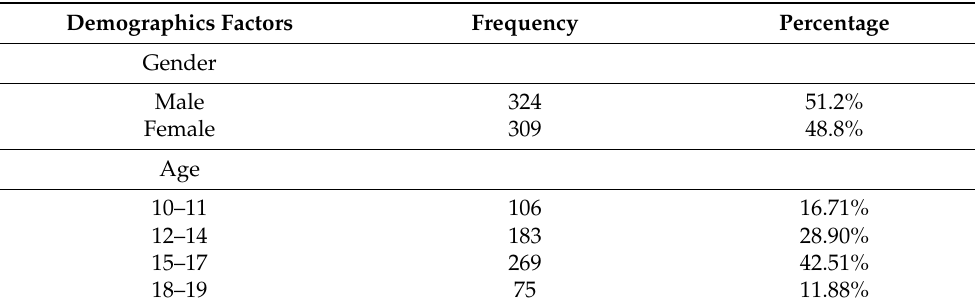
Table 1. Demographic Profile of Respondents ( n =